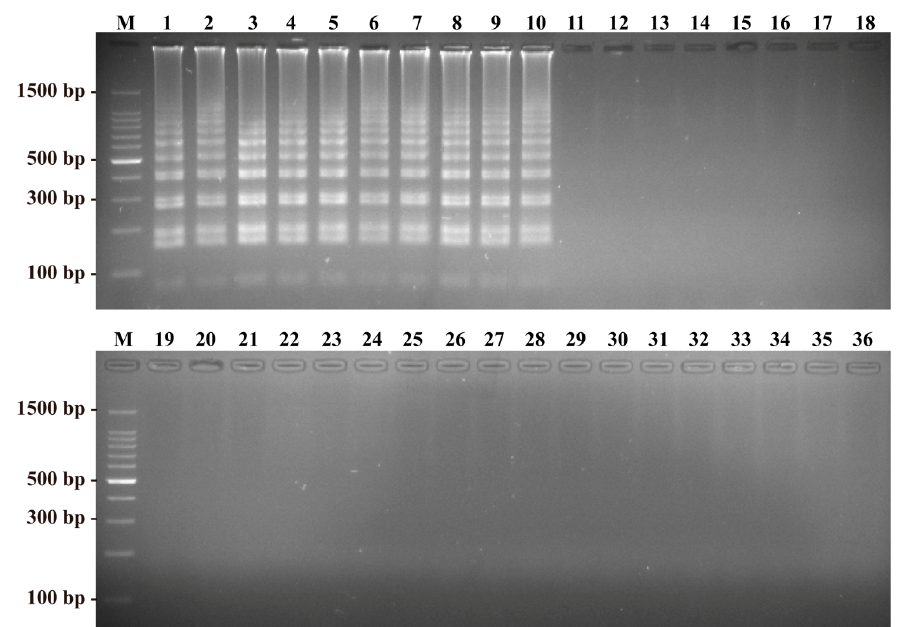
Figure 4. Specificity of the LAMP detection for different strains. Lane M, DL 50-bp DNA marker; Lane 1–10, different B. quintana strains; Lane 11–23, other Bartonella reference strains of B. henselae ,